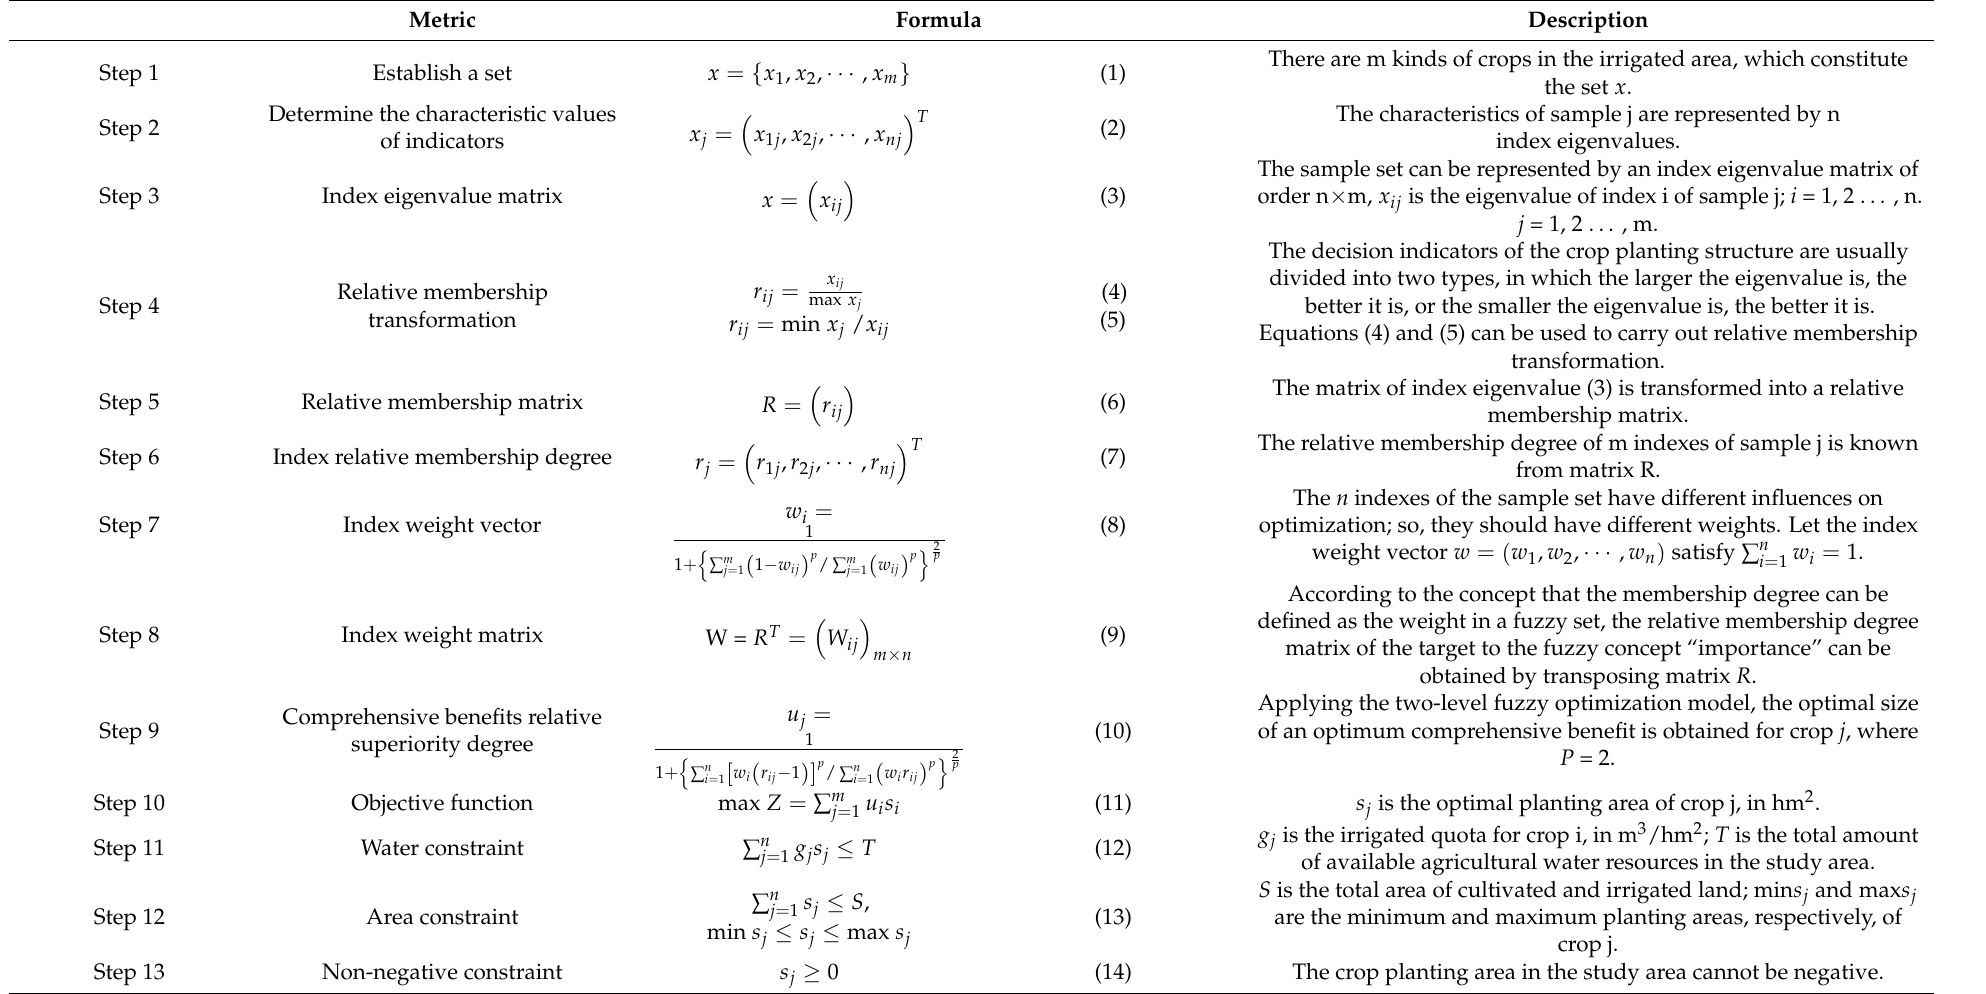
Table 2. Steps of building multi-objective fuzzy optimization